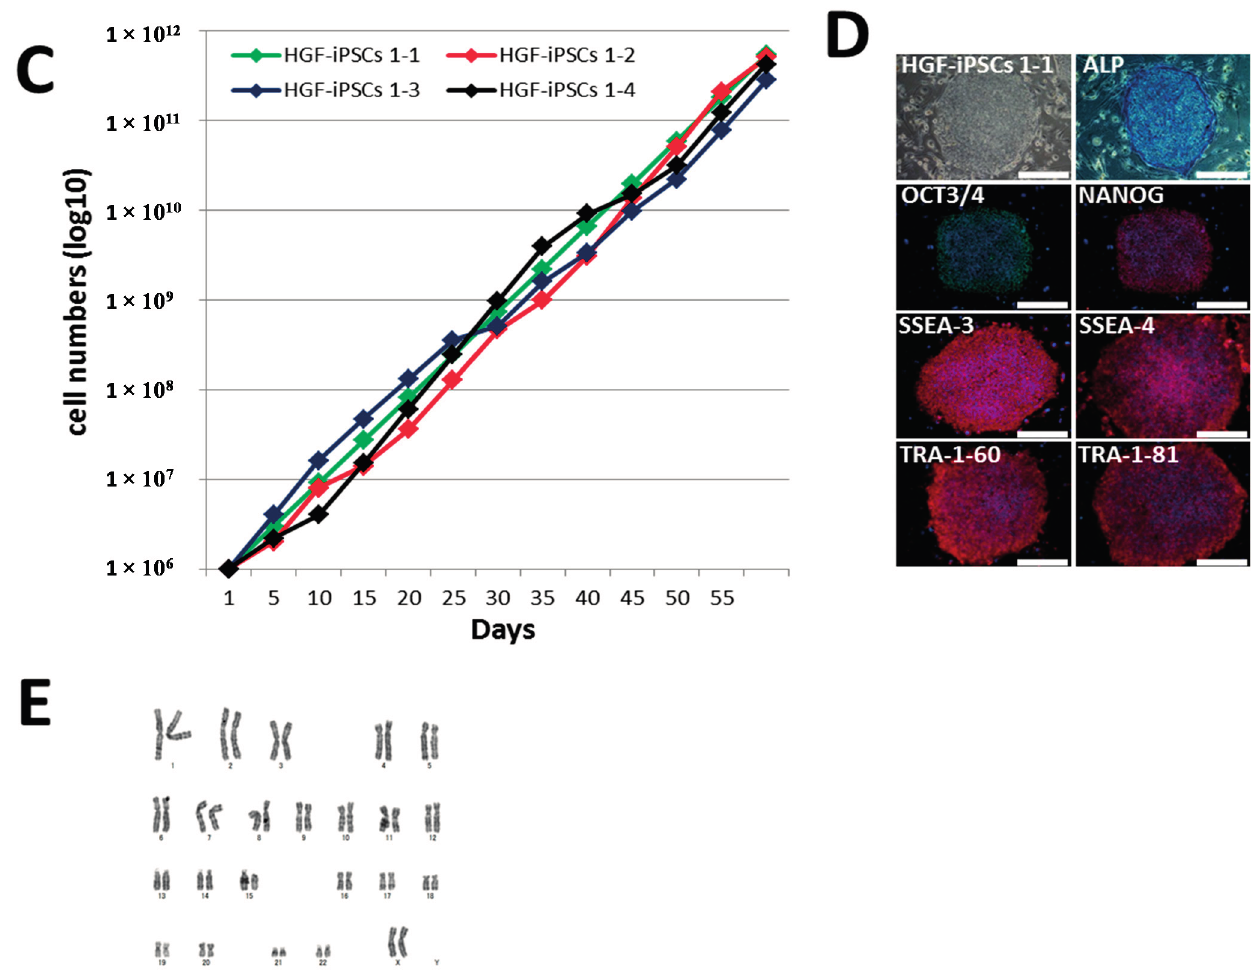
Figure 1. Characterization of induced pluripotent stem cells generated from human gingival fibroblasts (HGF-iPSCs). ( A ) Quantitative RT-PCR of four HGF-iPSCs, 1-1 (passage 25), 1-2 (passage 20), 1-3 (passage 21), and 1-4 (passage 20), of pluripotency-related gene expression (OCT3/4, NANOG, SOX2, KLF4, REX1, CMYC, TERT, and DPPA5). KhES-1 cells (passage 23) were used as positive control and human gingival fibroblasts (HGFs) (passage 6) as negative control were used; ( B ) Expression of episomal vector transgenes in human HGF-iPSCs, HGFs (passage 6) as negative control, and HGFs on day 1 after transduction (TF d1) with episomal vectors as positive control. QRT-PCR data represent mean ± standard deviation (SD) of three independent experiments; ( C ) Growth curve of four HGF-iPSCs; ( D ) Morphology of HGF-iPSCs 1-1 cultured on SNL feeder (passage 26). Established HGF-iPSC line 1-1 was stained to identify any ALP activities and for OCT3/4, NANOG, SSEA-3, SSEA-4, TRA-1-60, and TRA-1-81. Scale bar = 400 μ m; ( E ) Karyotype analysis of iPSCs 1-1 at passage 26 by G-band